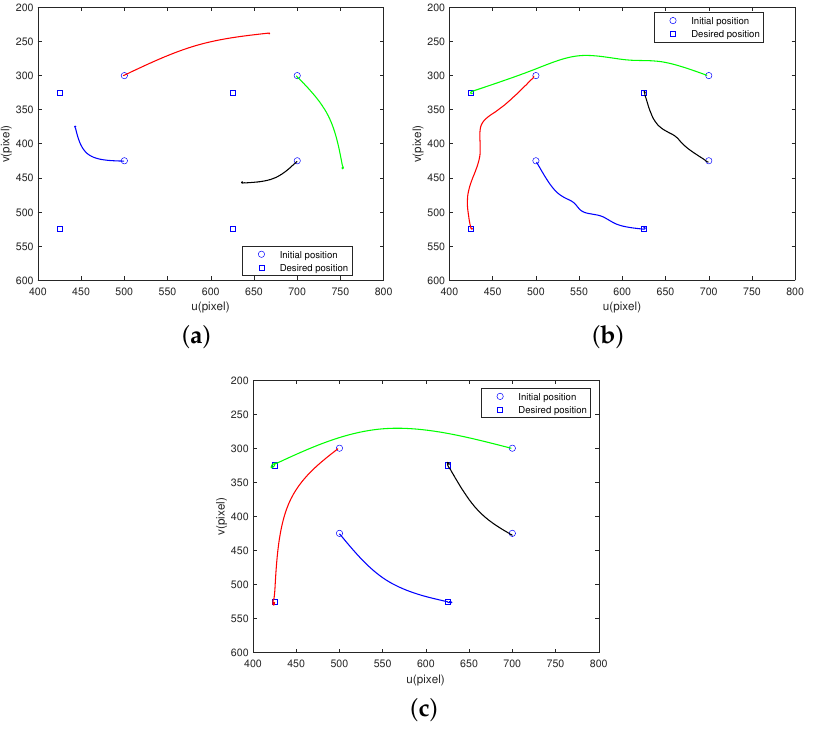
Figure 4. Trajectories of the image features of comparative simulations with model uncertainty. ( a ) Trajectories of the image features in Case 1. ( b ) Trajectories of the image features in Case 2. ( c ) Trajectories of the image features in Case